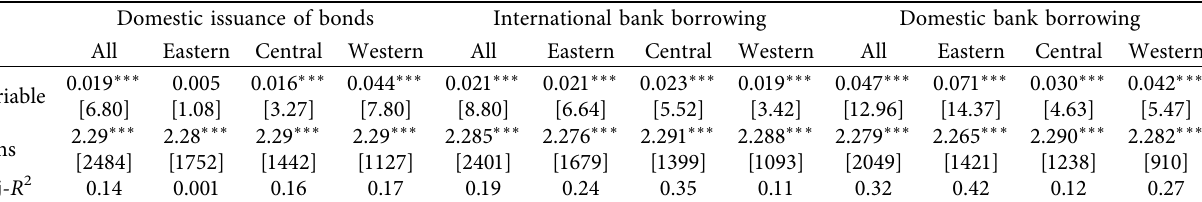
Table 9: Direct governance efects of borrowing debt.